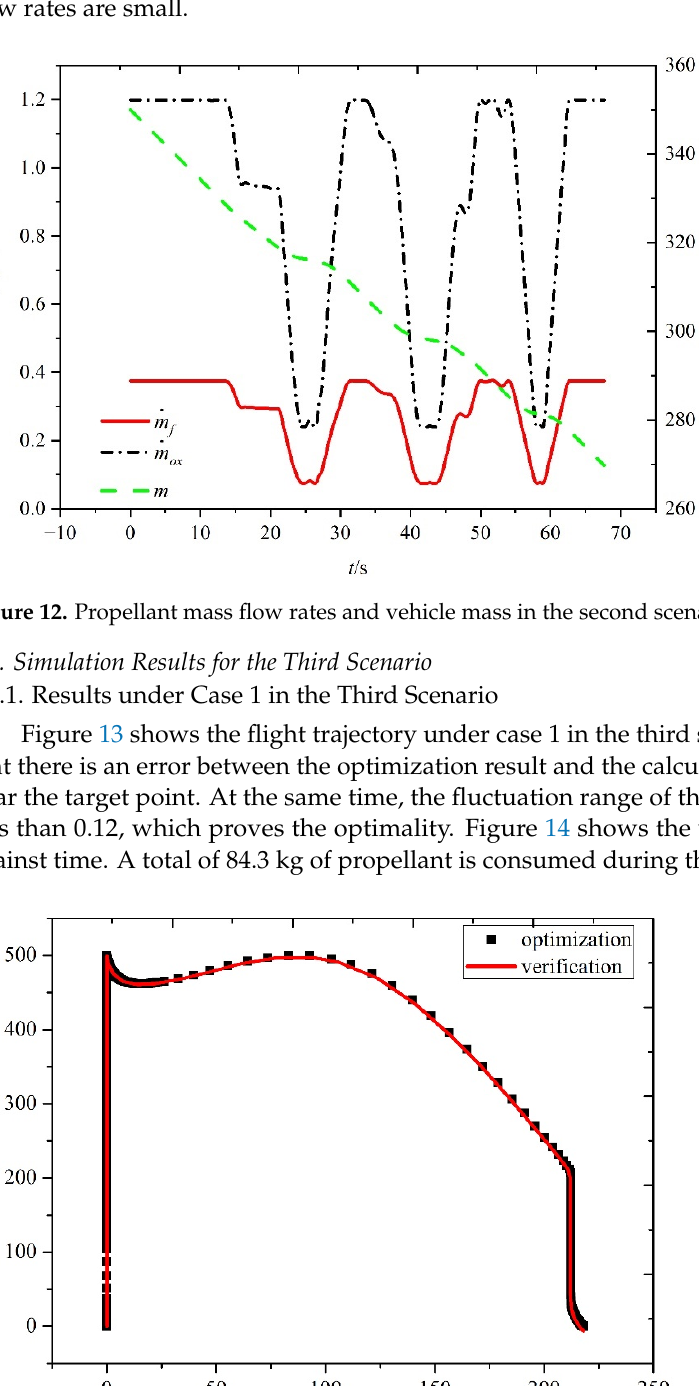
Figure 11. Thrust in the second scenario vs. time.